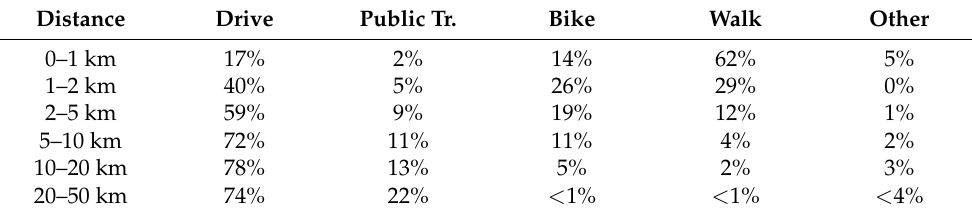
Table 2. Proportions of each type of transportation means for 1 to 50 km trips in Brussels [25,26]. Distance Drive Public Tr. Bike Walk Other